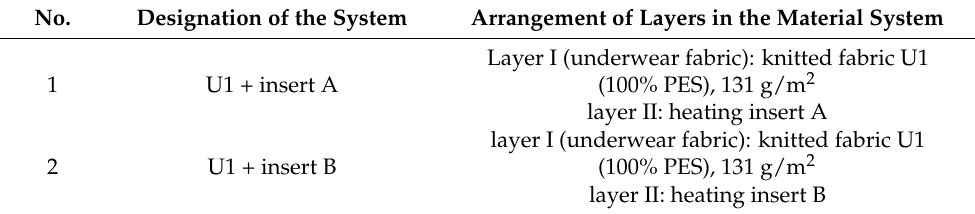
Table 3. Variants of the tested material systems.